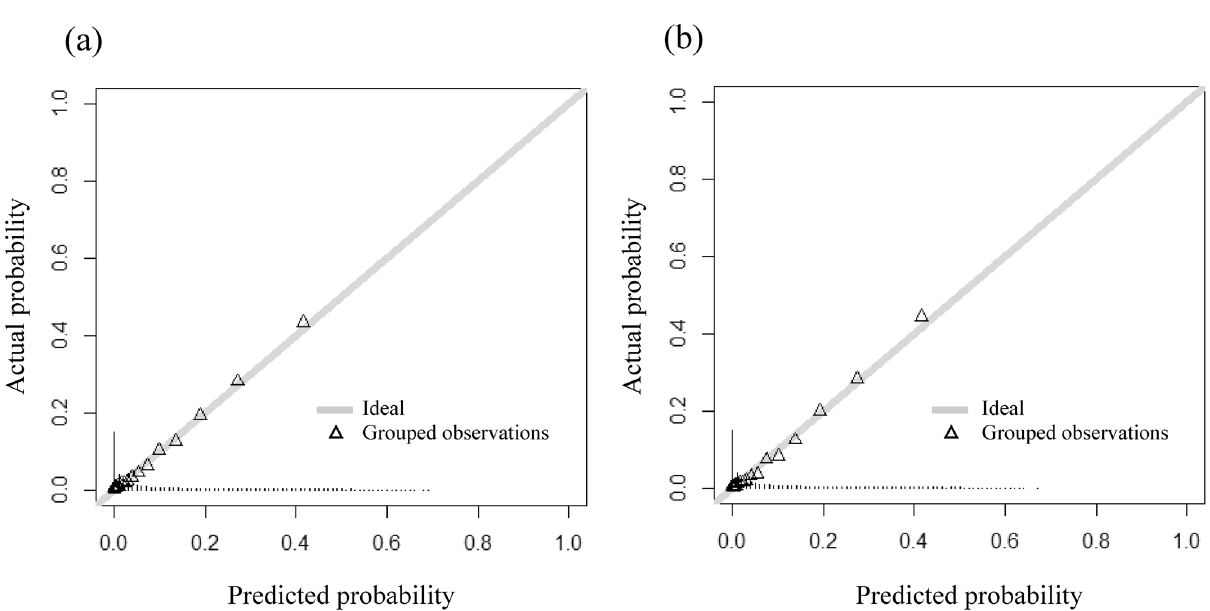
Figure 4. Calibration plots for the equation model in derivation and validation cohorts. The visual agreement between the CKD predictions (Predicted probability) and observations (Actual probability) for the equation model in the derivation and validation cohorts. ( a ) derivation cohort ( b ) validation